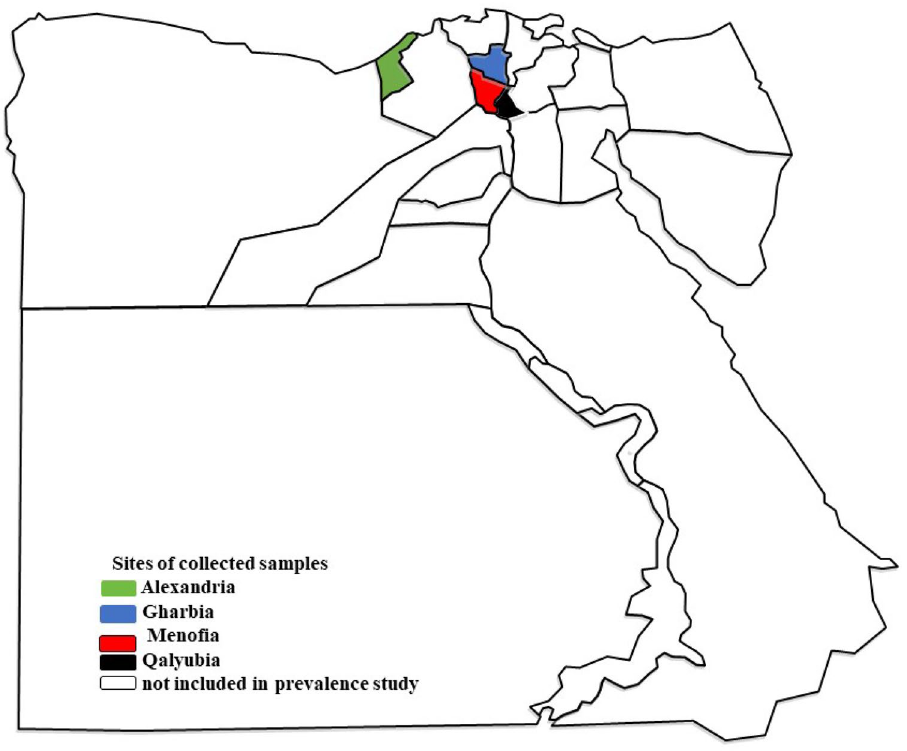
Figure 1. Geographical distribution of governorates under the study. Map was generated using QGIS software ver. 3.18.3. (https:// qgis. org/ en/